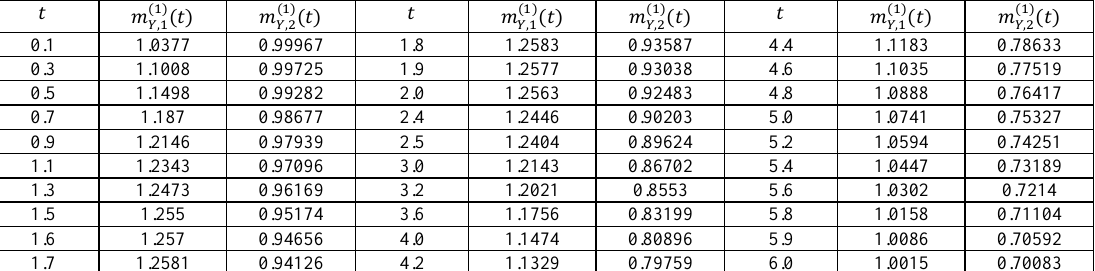
Table 4. One mutation: comparison of growth of normal cells